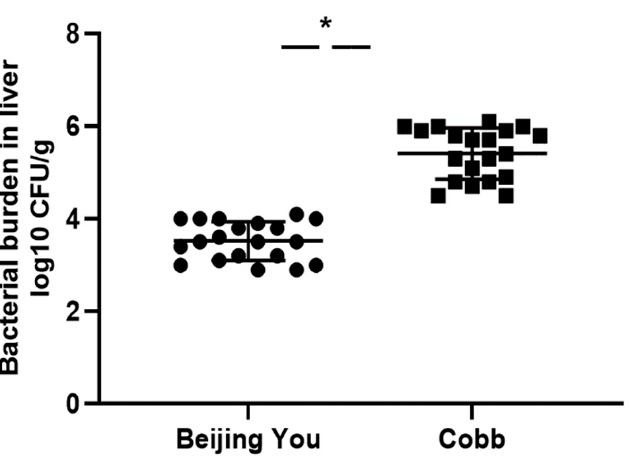
Figure 1. Bacterial burden in the liver 1 day after oral infection of chicks with 2.4 × 10 12 CFU ST/chick. The results are presented as individual values, mean ± standard deviation, * p < 0·05.